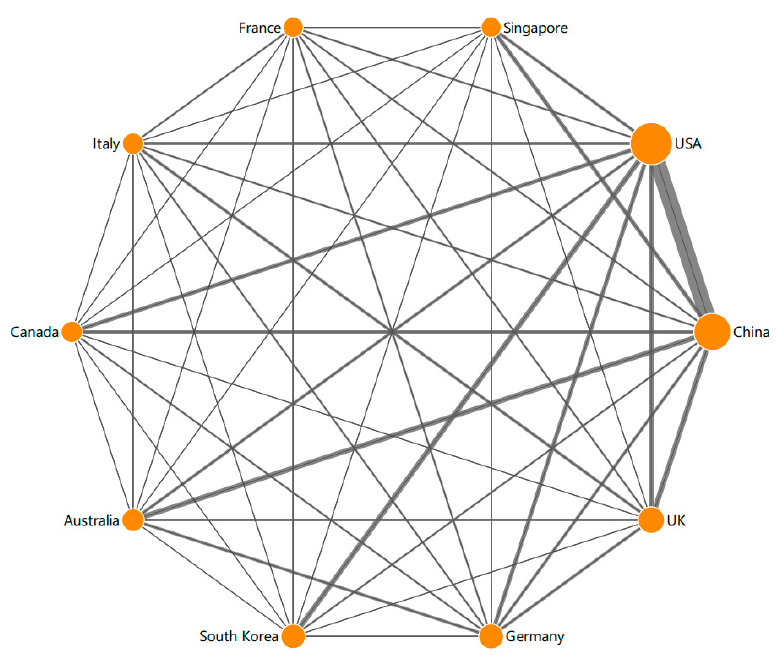
Figure 4. Collaboration matrix map among the top 10 productive countries.